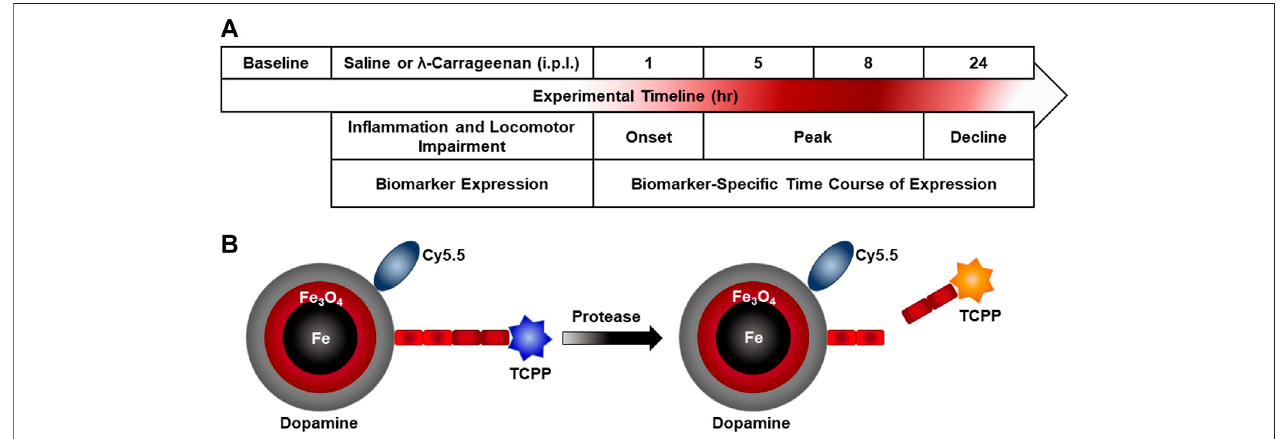
FIGURE 1 | Experimental timeline and nanobiosensor schematic. (A) Paw in fl ammation, non-evoked in fl ammatory pain behavior, and biomarker expression were assessedpriortointraplantar(i.p.l.)treatmentwithsalineor λ -carrageenan.Theanticipatedtimelineof λ -carrageenanonthesemeasuresat1 – 24 hfollowingtreatmentis noted. (B) The schematic provides an overview of nanobiosensor technology for protease activity detection which consists of a dopamine-coated iron/iron oxide nanoparticle, amide-tethered cyanine 5.5 (Cy 5.5) and tetrakis-carboxyphenyl-porphyrin (TCPP), that is, attached via a consensus sequence. Upon addition of a protease (MMP-2 and MMP-9), the consensus sequence is cleaved and TCPP is released and subsequently switches on TCPP fl